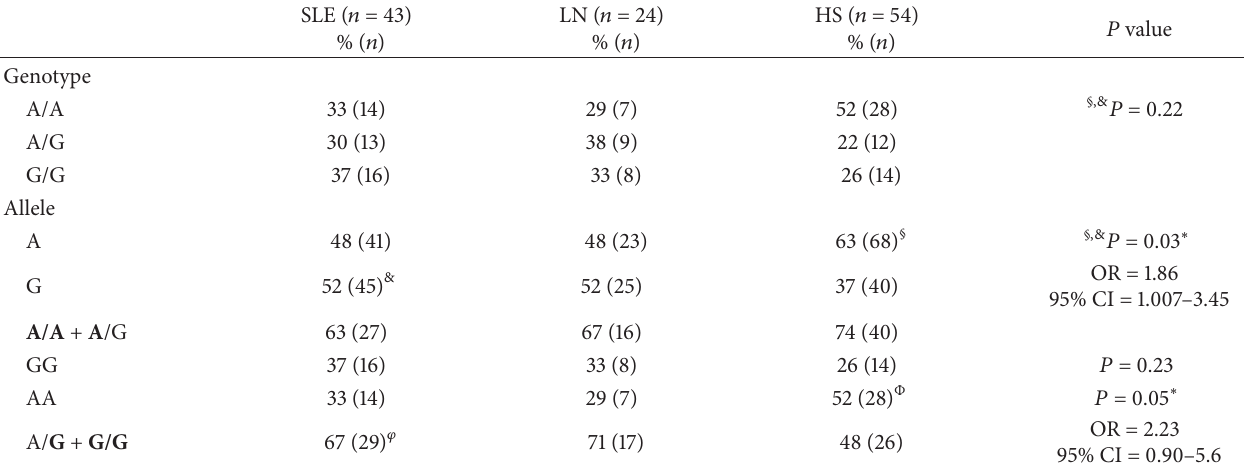
Table 1: Genotype and alleles frequencies of the − 670 A/G Fas polymorphism in SLE and LN patients and HS.